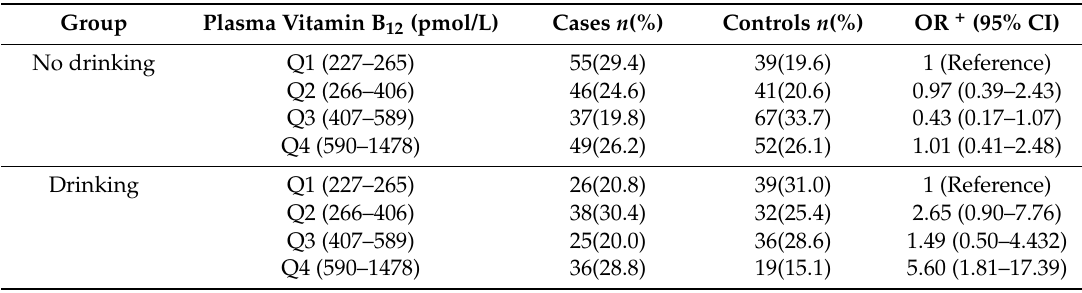
Table 5. Stratified analyses of Odds ratios and 95% confidence intervals of HCC with plasma vitamin B 12